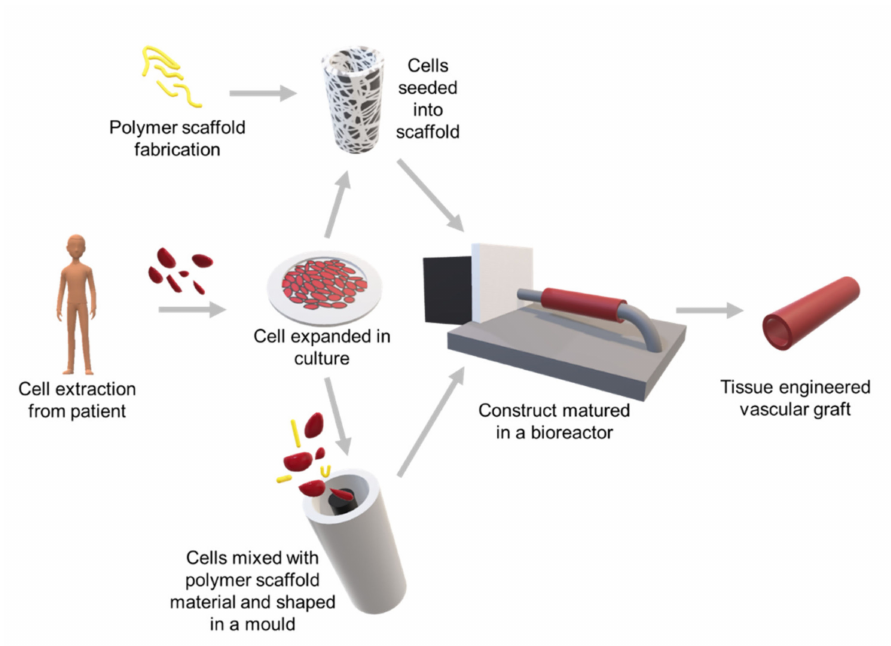
Figure 4. The process of producing a tissue engineered vascular graft through sca ff old-based method. The patient’s cells are harvested, then isolated and cultured in vitro before seeded into a sca ff old or mixed together with a polymer sca ff old material in a tubular mould. Additional conditioning and culturing in a bioreactor is required. Image adapted from